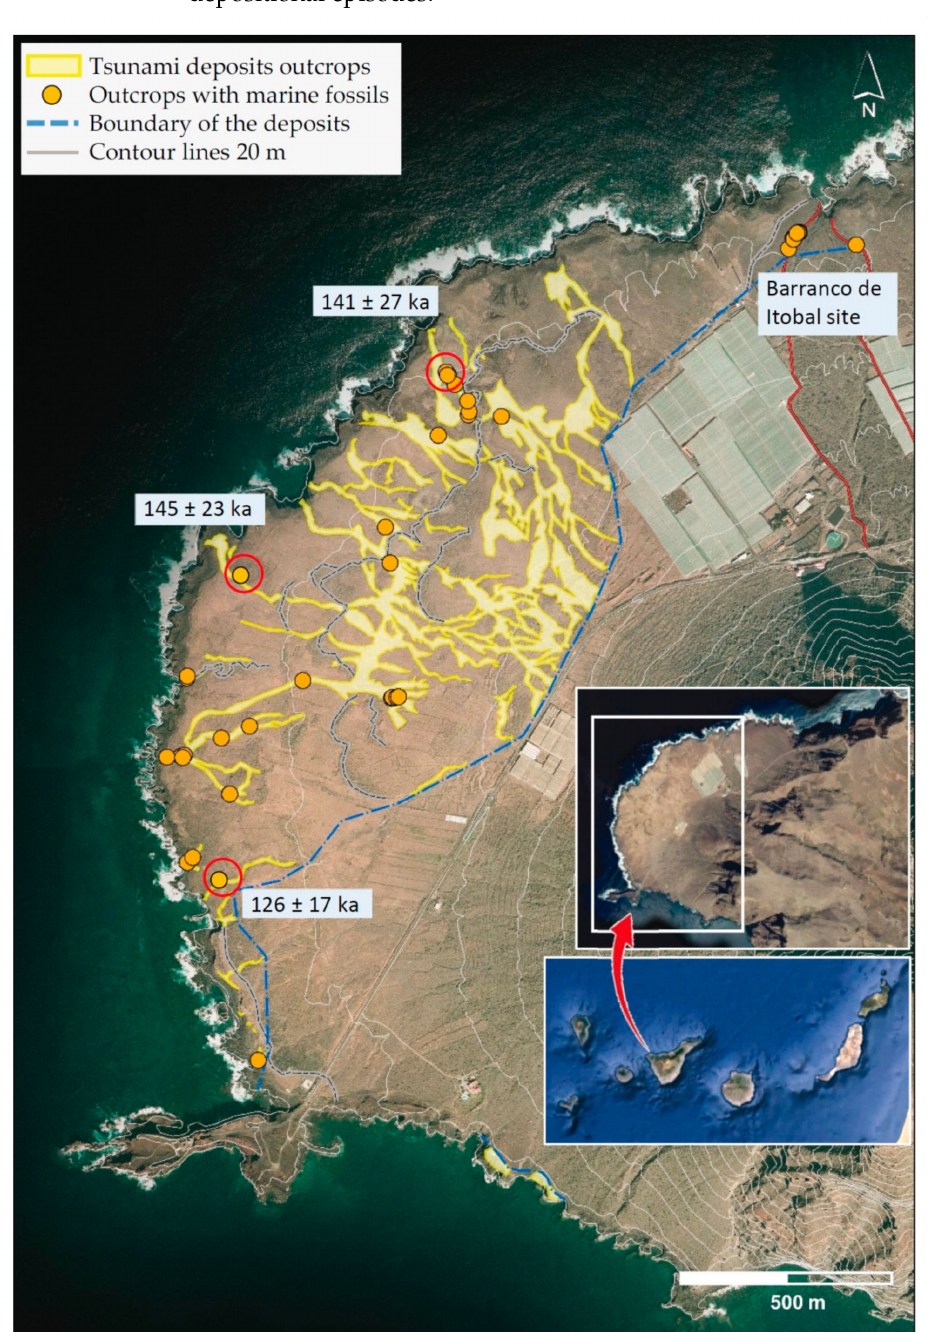
Figure 2. Map of the tsunami deposits overlying the Teno lava platform obtained from a field survey, cropping out the areas where the alluvial cover was removed by erosion. The Barranco de Itobal site is located to the northeast, where the tsunamigenic sediments have maximum thickness. Ages obtained in this study by AAR analysis are included (red circles). PNOA and Google Earth